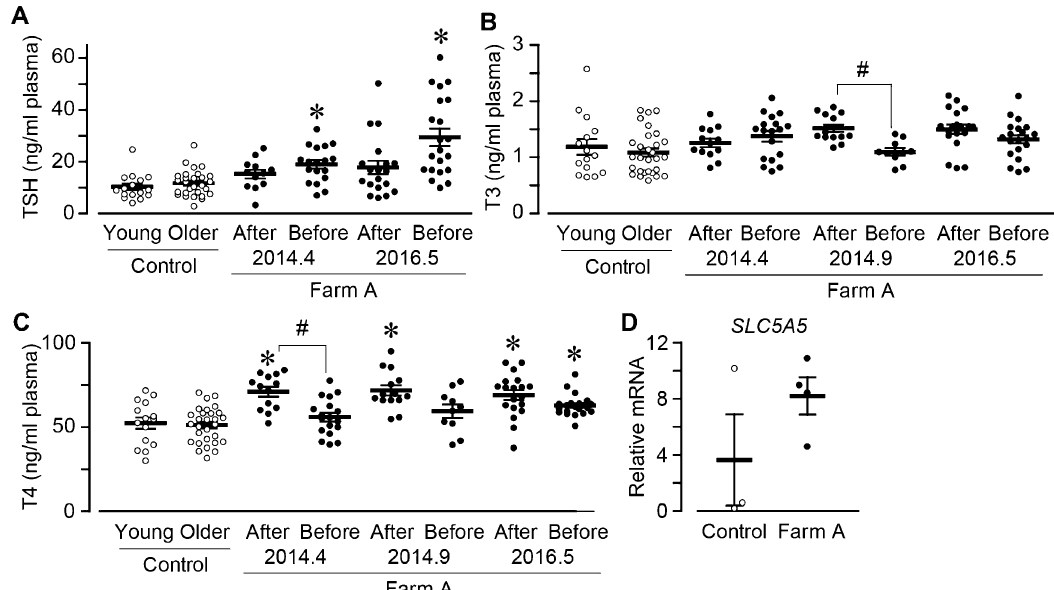
Figure 6. The level of thyroid hormones in plasma. ( A – C ) Plasma was collected in 2014–2016 and the levels of thyroid hormones were measured. The summary of ( A ) TSH (Control, open circle, n = 15 and 29; Farm A, black circle, n = 13, 18, 19, and 21), ( B ) T3 (Control, open circle, n = 15 and 29; Farm A, black circle, n = 14, 18, 14, 10, 19, and 21), and ( C ) T4 (Control, open circle, n = 15 and 29; Farm A, black circle, n = 14, 18, 14, 10, 19, and 21). ( D ) The summary of thyroid mRNA level of NIS ( SLC5A5 ; control, open circle, n = 3; Farm A, black circle, n = 4). Data are presented as mean ± SEM. *P < 0.05 compared with the control group. # P <